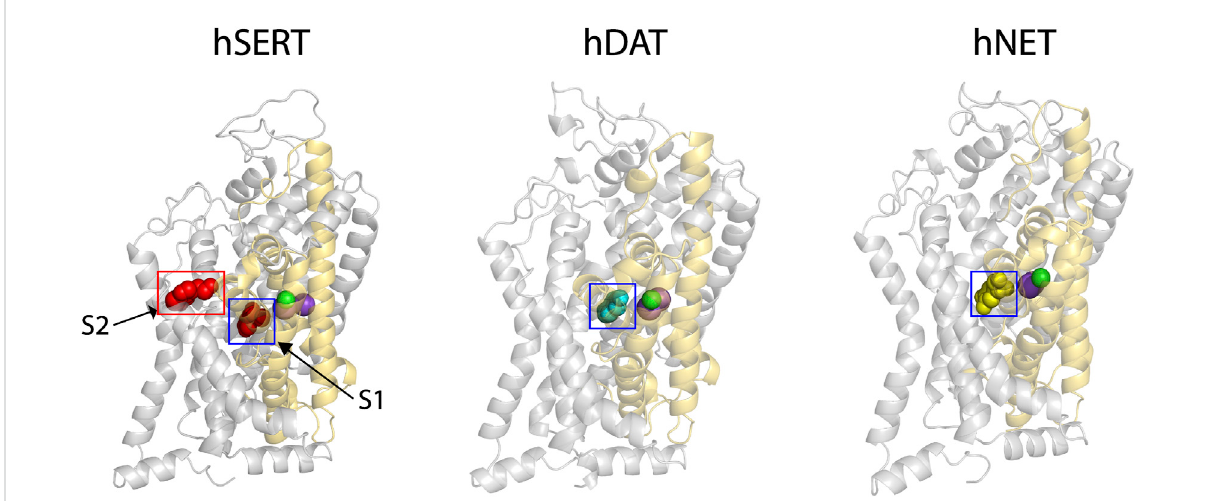
FIGURE 1 The cryo-EM structure of hSERT and homology models of hDAT and hNET. Two substrate ( red spheres )-bound sites, the central site (S1, blue square ) and allosteric site (S2, red rectangle ), were localized in the cryo-EM structure of hSERT in an outward open conformation (PDB ID, 7LIA, left ) (Yang and Gouaux, 2021). The homology models of hDAT ( middle ) and hNET ( right ) bound with the corresponding substrate in the S1 site ( cyan spheres for dopamine and yellow for norepinephrine) were generated with Modeller based on an outward-facing structure of the Drosophila melanogaster DAT(2.89 Åresolution,PDBID,4XP1).TwoNa + ( purplespheres )andoneCl − ( greenspheres )ionsareshowninthebindingsiteofeach transporter. The core and scaffold domains in each transporter are shown in golden and grey,